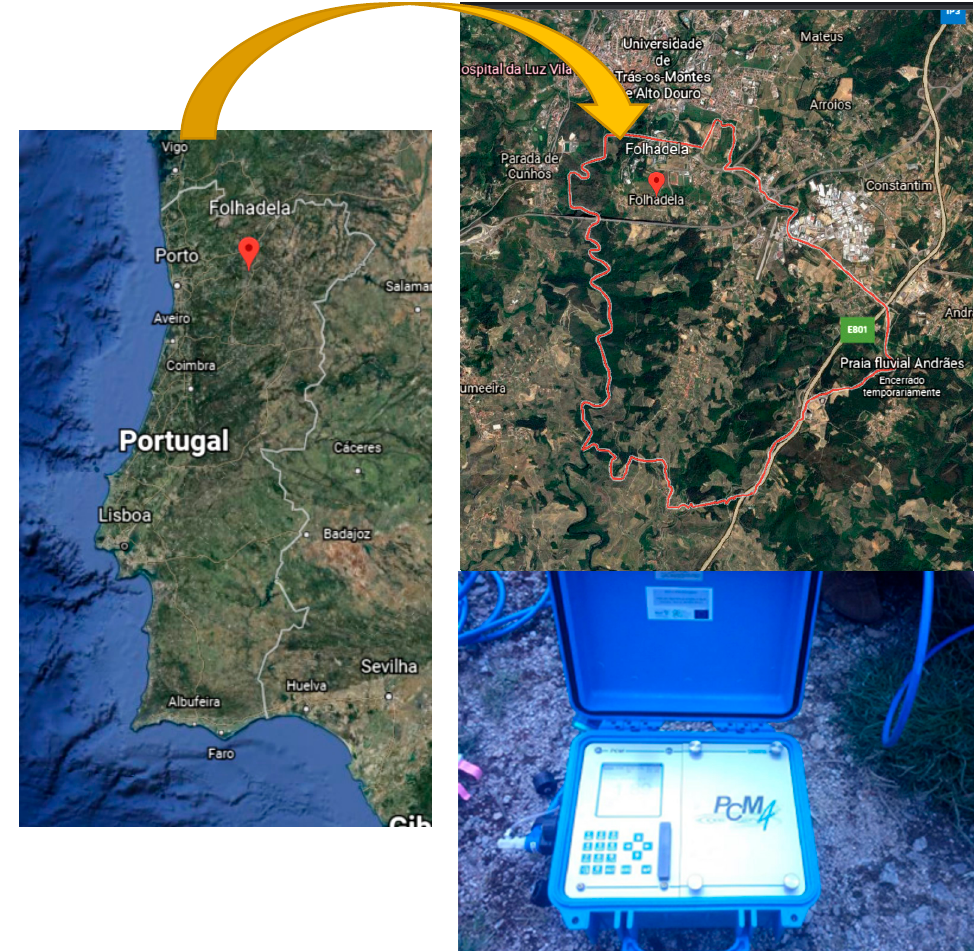
Figure 1. Folhadela location and flow meter used in the case study.